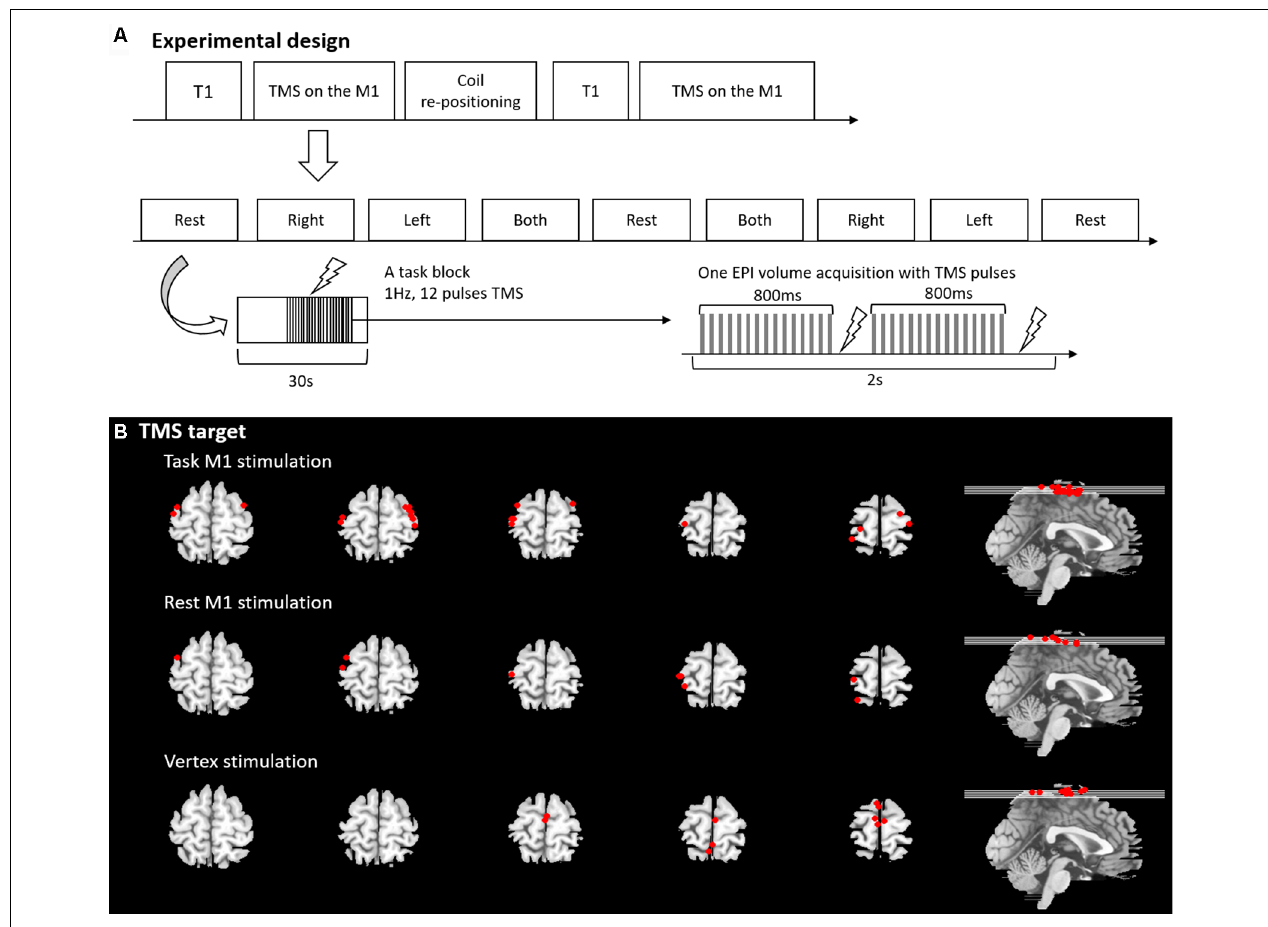
FIGURE 1 | (A) Experimental design and procedure. (B) Transcranial magnetic stimulation (TMS) target position.